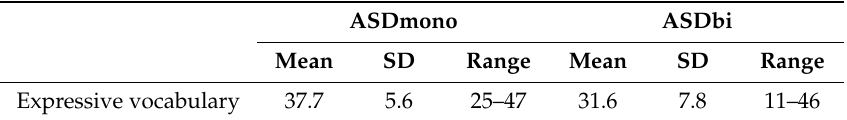
Table 2. Expressive vocabulary performance in monolingual and bilingual children with autism spectrum disorder (ASD).